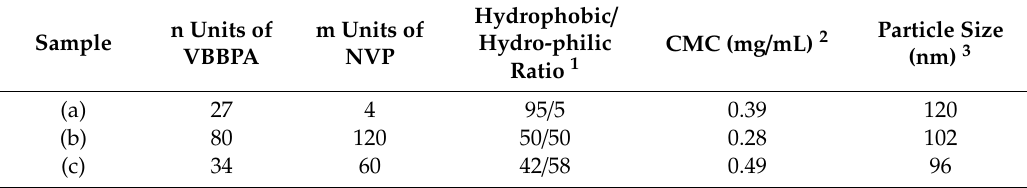
Figure 4. Reversible addition–fragmentation chain transfer (RAFT) polymerization kinetics of PVBXPA with NVP (NVP / PVBXPA / AIBN = 20 / 1 / 0.1 at 60 ◦ C; [NVP] 0 = 4.0 M in anisole). Table 1. Characterization of PVBPA n - g -PNVP m bottlebrushes.